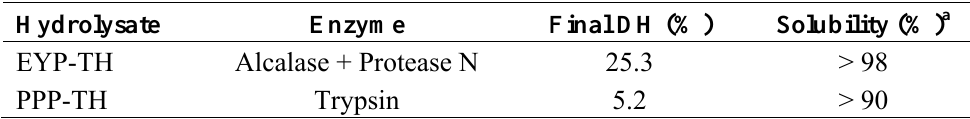
Table 1. Degree of hydrolysis and solubility of egg yolk proteins (EYP) and phosphoproteins (PPP)